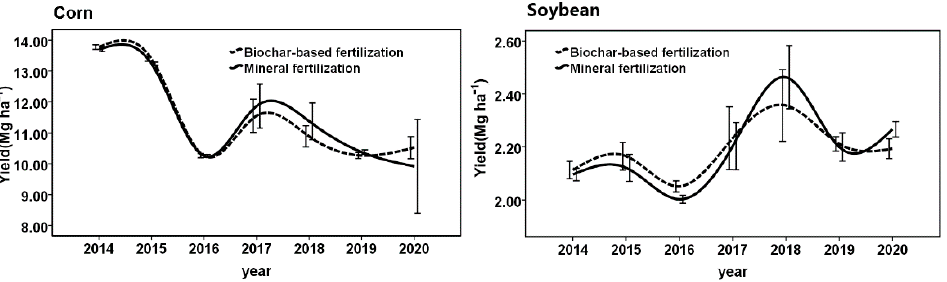
Figure 4. Effect of fertilization treatment on grain yield in a long-term study.